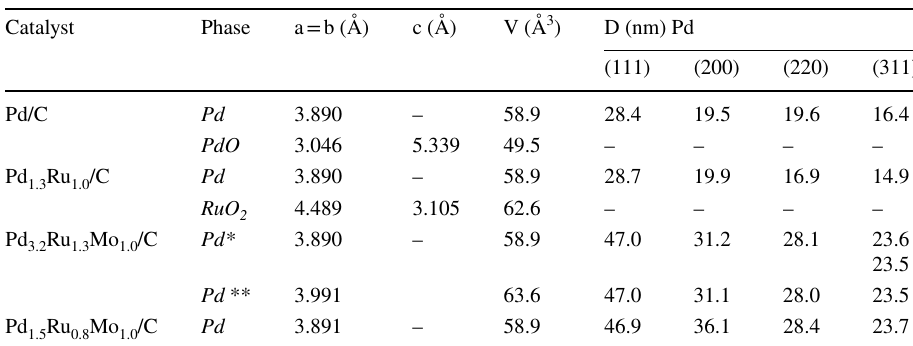
characterization of catalysts using XRD